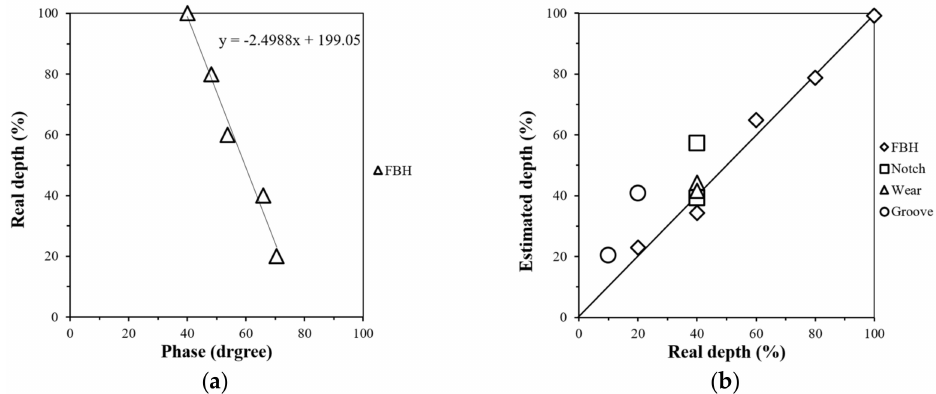
Figure 18. Phase angle change according to the flaw depth: ( a ) Relationship between depth and phase angle di ff erence of the flaws (front bobbin coils, 100 kHz AC), and ( b ) quantitative analysis of depth of the